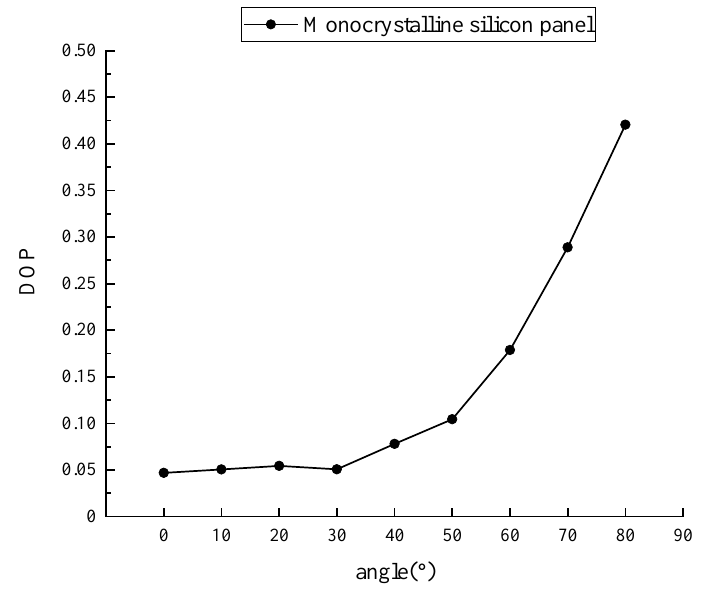
Figure 17. DOP curve of monocrystalline silicon solar panel with view angle.